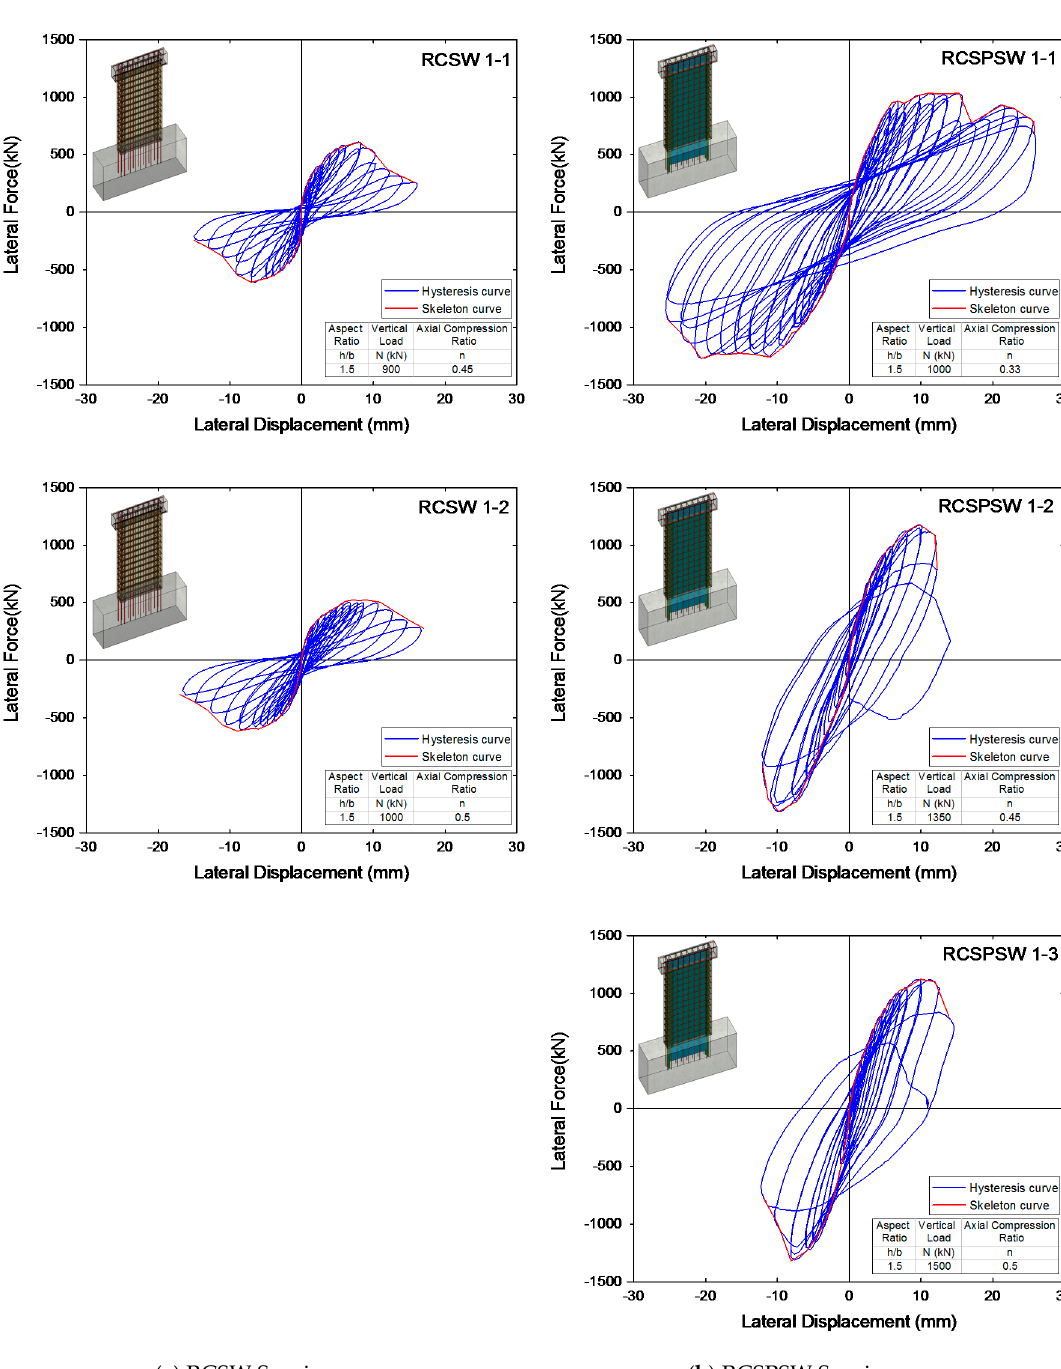
Figure 10. Hysteresis and Skeleton Curves for Specimens with Aspect Ratio of 1.5 ( a ) RCSW Specimens and ( b ) RCSPSW Specimens.